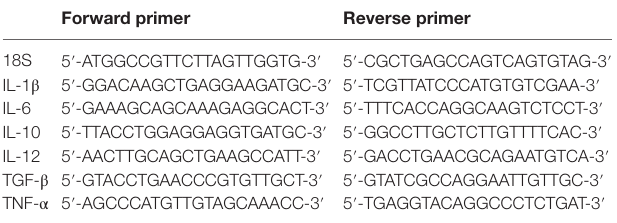
TaBle 1 | Primers used for quantitative real-time